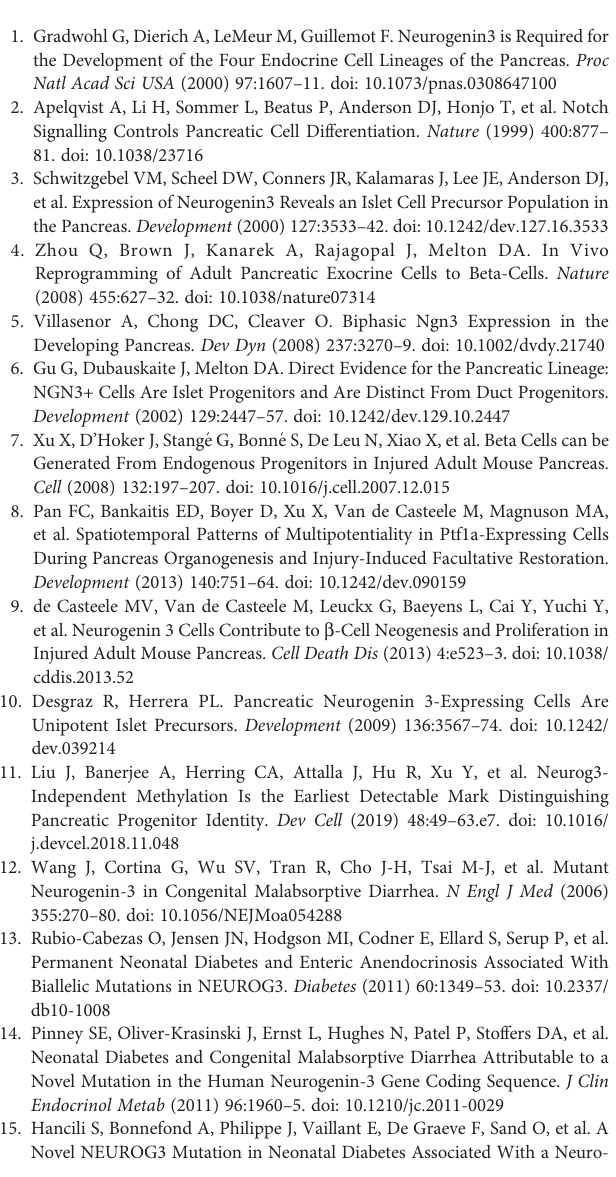
differentiation from human embryonic stem cells to beta cells. (B) UMAPs display relative marker gene expressions. Color scale is based on normalized expression values. (C) UMAP demonstrates the partial alignment of the Endo1, Endo2, Endo3, andDuctalcellsfromthe Krentzdatawithmaturebeta,alpha,delta,andductalcells correspondingly. (D) NEUROG3+ cells scatter into multiple regions of the UMAP rather than form a unique cluster. Left panel, the 10 NEUROG3+ cells in the current study are shown in red and the NEUROG3+ from the Krentz dataset are shown in yellow. Other cells are colored grey. EP, annotated NEUROG3+ endocrine progenitors. Right panel, the level of the NEUROG3 expression is shown. Supplementary Figure 5 | Validation of the integrated single-cell RNA-seq dataset with a single-nucleus RNA-seq dataset. (A) Scatter plot exhibits the expression levels of NEUROG3 in different populations. (B) Venn diagram demonstrates the overlap of the top 50 most highly expressed transcription factors in the datasets. The signi fi cance of the overlap is calculated based on hypergeometric